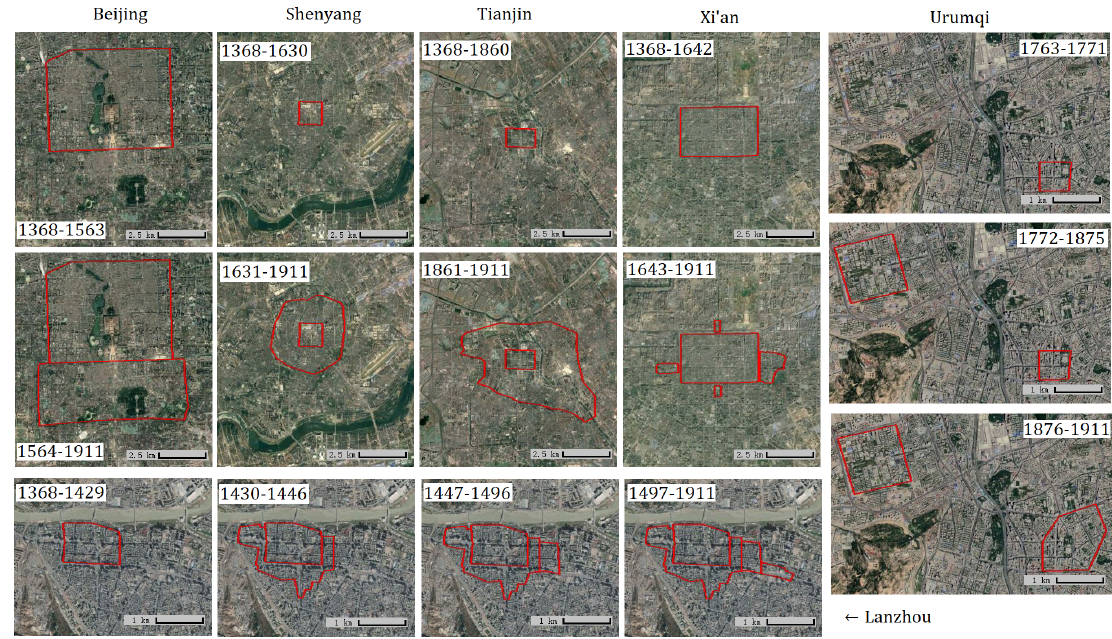
Figure 6. Several extents of city walls of Chinese cities from 1368 to 1911. The red aerials are from the China City Wall Areas Dataset (CCWAD) which illustrate the location of city walls. These maps are based on © Google Earth image,